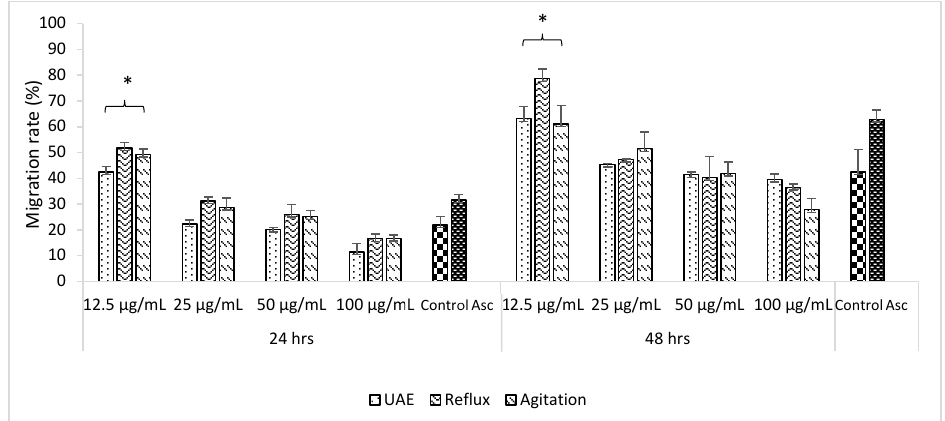
Figure 3. Effect of C. papaya extracts obtained from UAE, reflux, and agitation extraction techniques on the migration and proliferation rate of scratch HSF1184 cells. The migration rate was analyzed by using Image-J software. Results are expressed as the mean ± SEM of three independent experiments.